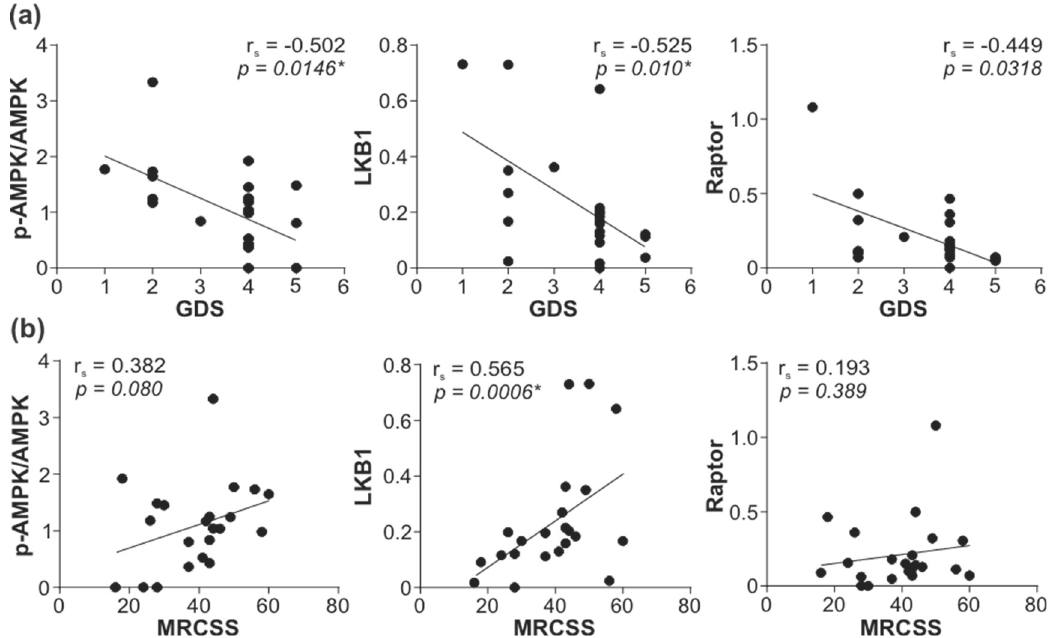
Figure 4. Correlation between leukocyte AMPK signaling and GBS severity. The levels of total LKB1, phospho/total AMPK ratio, and total Raptor in PBMCs of GBS patients were determined by immunoblotting, and the correlations with ( a ) GDS ( n = 23) and ( b ) MRCSS ( n = 22) were assessed (r s —Spearman’s correlation coefficient; * p < 0.05, Spearman’s rank-order test).